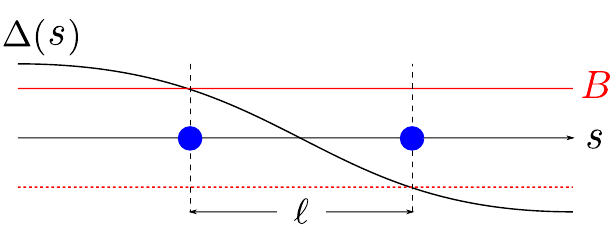
Figure 2: A spatially varying superconducting mass ∆ ( s ) (blue curve) and a constant magnetic field B (solid red line). The dashed red line is the curve − B . For a QSH edge with this configuration of ∆ ( s ) and B , single Majorana fermions (represented by the blue dots) are localized at the points where ∆ ( s ) = B and where ∆ ( s ) = − B . The central region where B ≥ | ∆ ( s ) | has a length (cid:96)